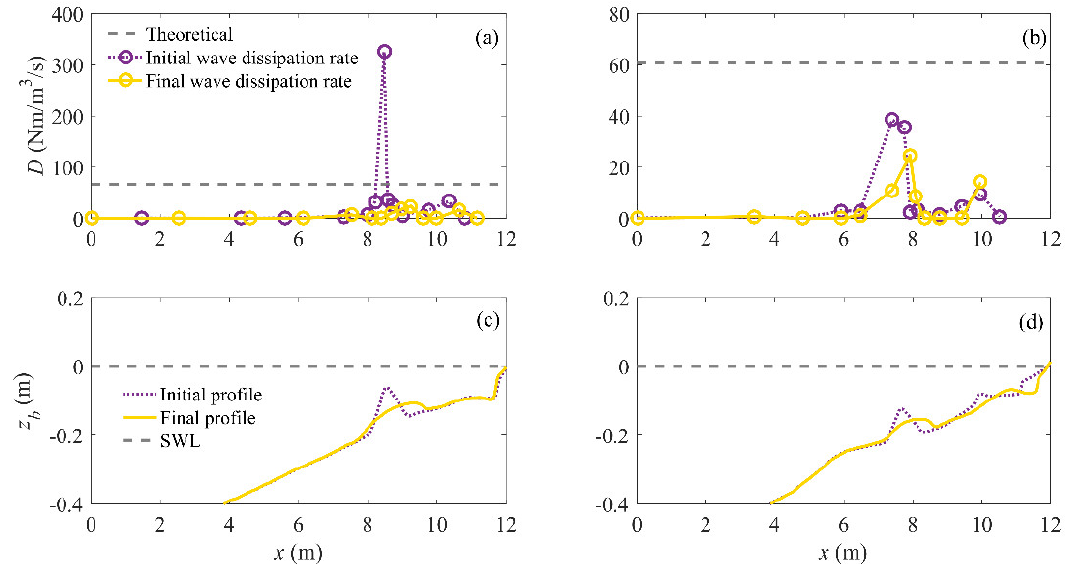
Figure 7. Wave energy dissipation rates corresponding to initial and final profile in case A1_2 ( a ) and ( c ), in case E1_1 ( b ) and ( d ).